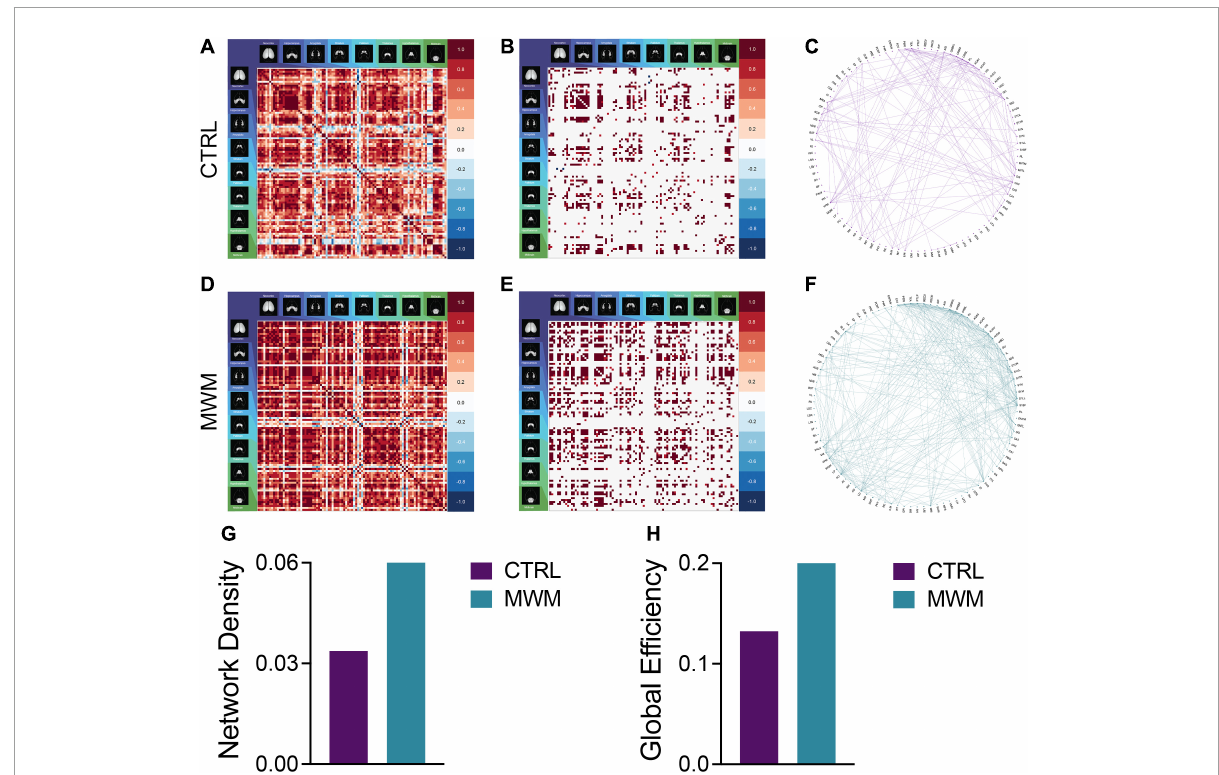
FIGURE3 Pairwise correlation matrices (A,D) , binarized adjacency matrices (B,E) and circle plots (C,F) showing significant correlations between regions for control (A - C) and Morris Water Maze trained (D - F) groups. See Supplementary Table 1 for full list of regions. MWM training increased (G) network density and (H) global network